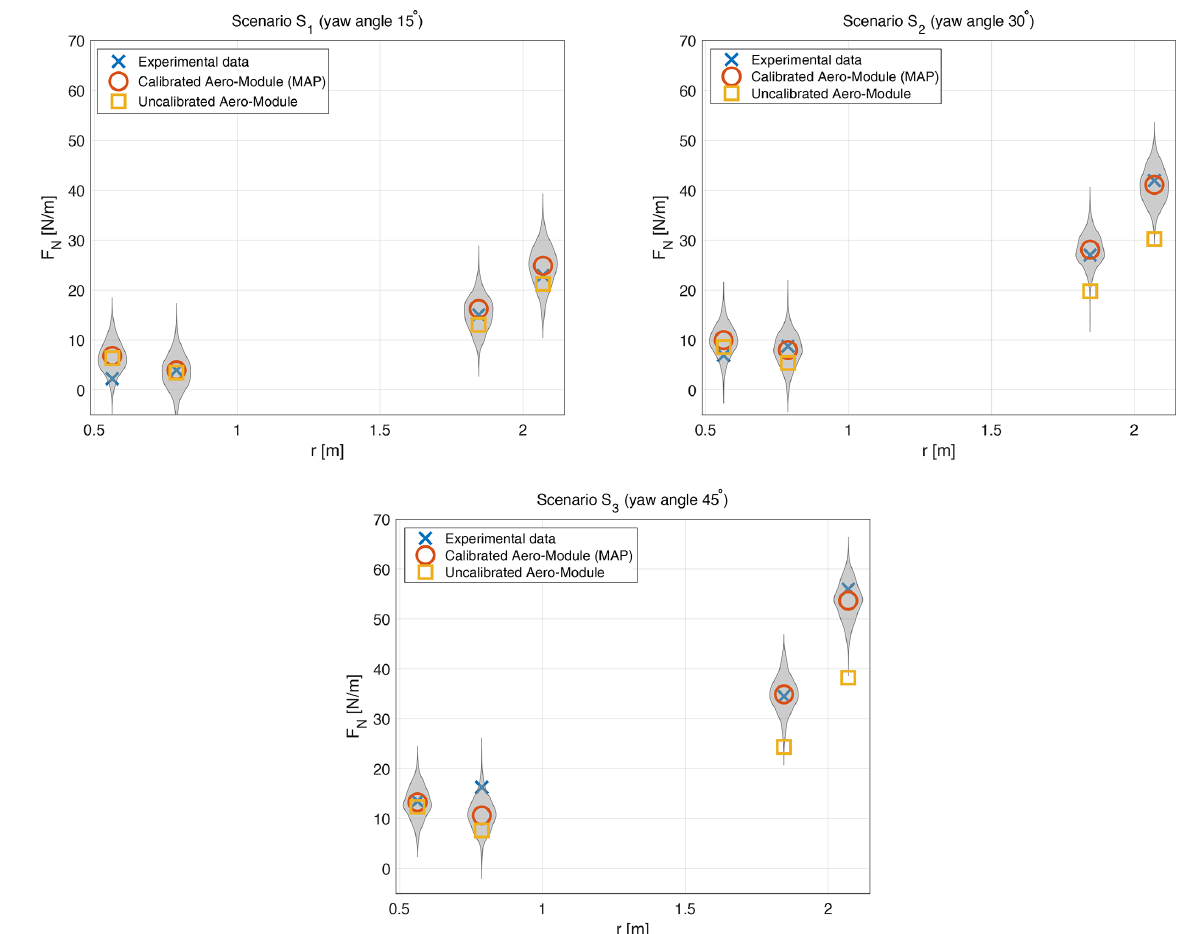
Figure 12. Comparison of uncalibrated and calibrated Aero-Module predictions with the New MEXICO measurements in terms of the normal force amplitude. The grey areas (violin plots) are constructed from 500 draws of the posterior predictive distribution. The Aero- Module predictions are obtained from the surrogate model and are essentially indistinguishable from the full Aero-Module results, which have therefore been omitted for the sake of